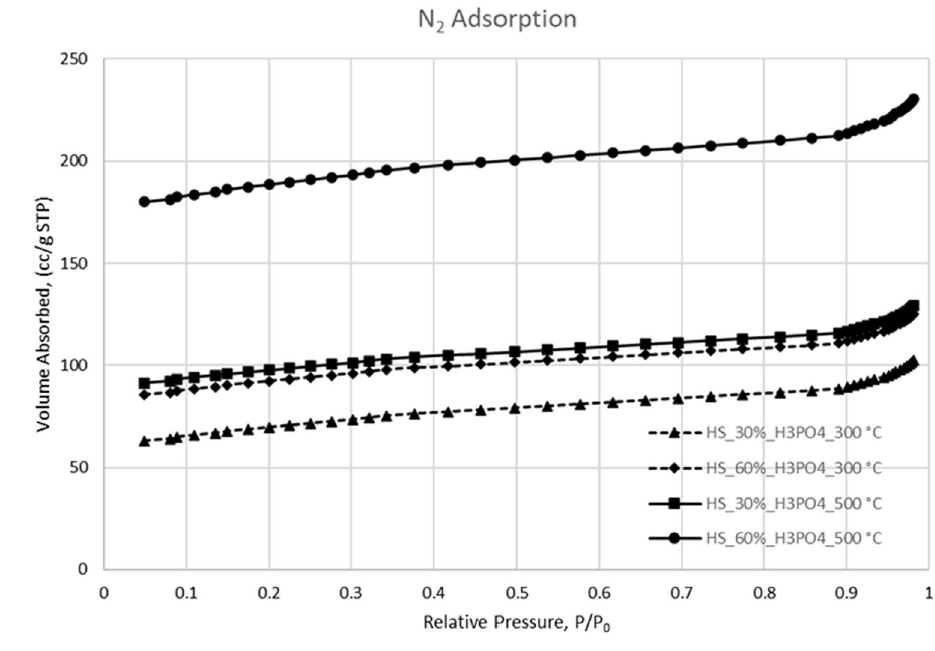
Fig. 6 N 2 isotherms for differ-